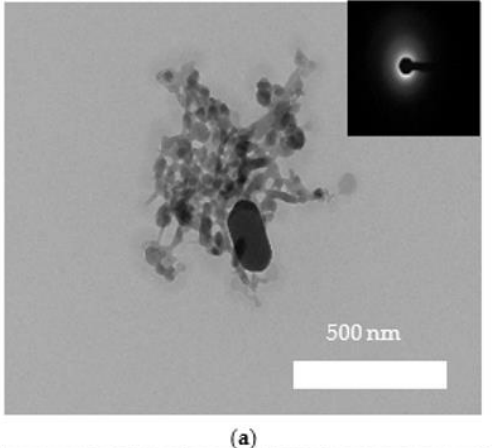
Figure 7. CaOx precipitates obtained during the post-nucleation stage in the absence of PAA. ( a ) and ( b ) TEM image and SAED pattern of hexagonal ACO nanoparticles, ( c ) and ( d ) FESEM images of different nanoparticles composed of platy euhedral nanoparticles. The precipitates obtained in the presence of PAA are disaggregated and exhibit clear morphological differences as compared with the control group. The CaOx particles ob- served by TEM have rhomboidal forms that are in close contact with drop-like particles of 50 to 250 nm in size that show filament-like projections suggesting the liquid nature of them (Figure 8a,b). SAED patterns confirm the precipitation of ACO structures at the post- nucleation stage. The FESEM images show the coexistence of nanocrystals with the typical pinacoid and bipyramidal forms of COT and COD hydrate phases (Figure 8c–f and Figure S5). Such crystals appear in conjunction with crystals showing pinacoid or hexagonal prism forms that aggregate adopting a tortuous shapeless structure (Figure 8c). The atyp- ical morphologies were formed possibly due to the rapid drying of liquid precursors as a result of quenching and the drying procedure, favoring the formation of crystal shapes with liquid-like appearance.